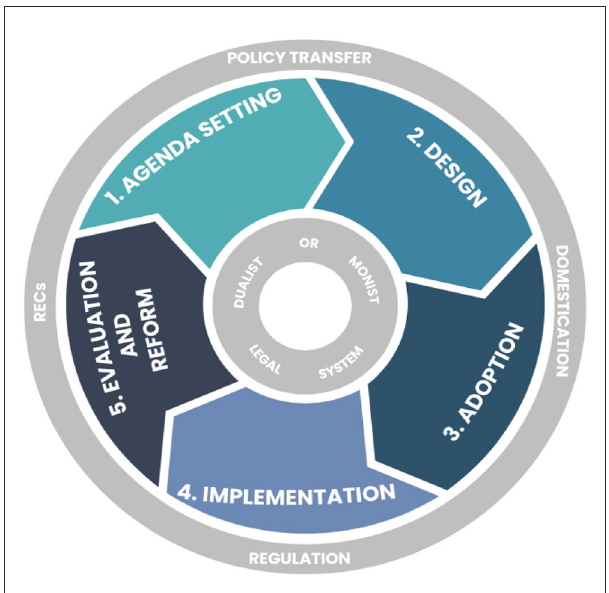
FIGURE1 Conceptual framework of policy transfer process: Source Author’s construction based on the policy